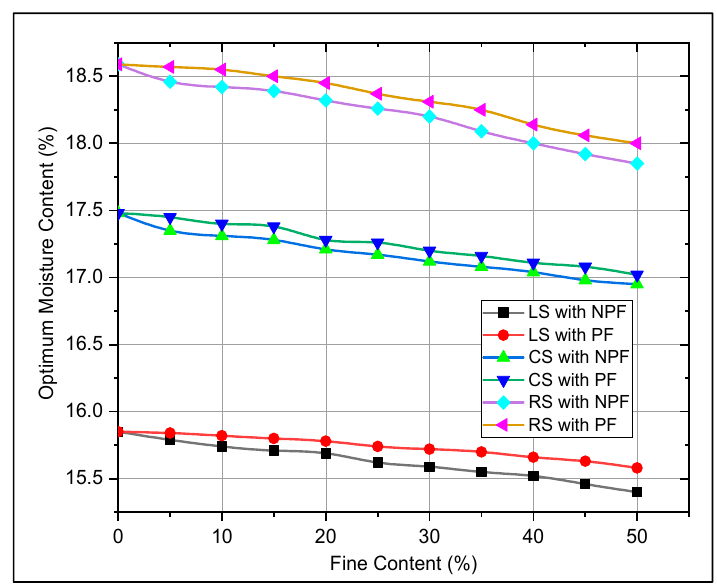
Figure 4. Variation in optimum moisture content with different fine contents.